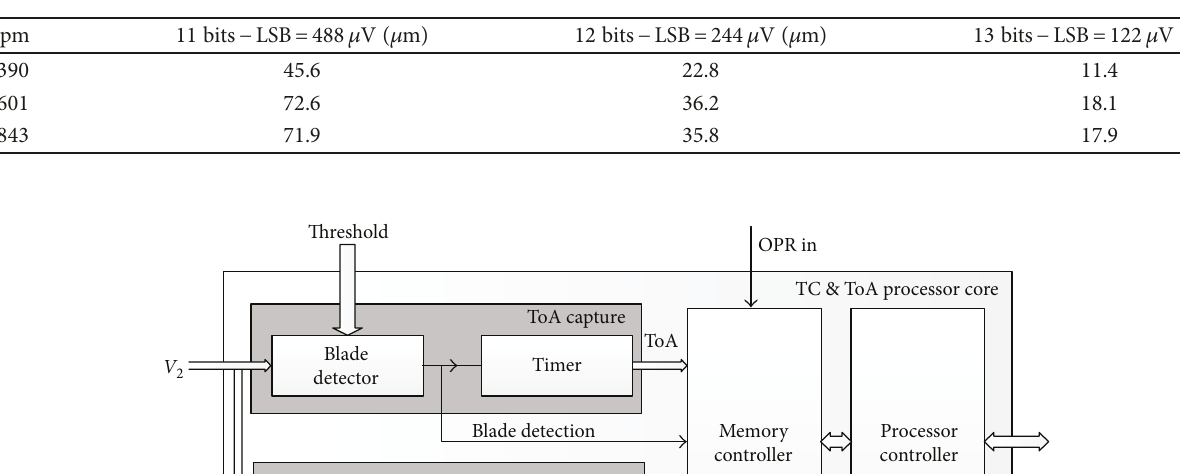
Table 2: Maximum Δ TC (in μ m) obtained from the test waveforms for di ff erent ADC resolutions.